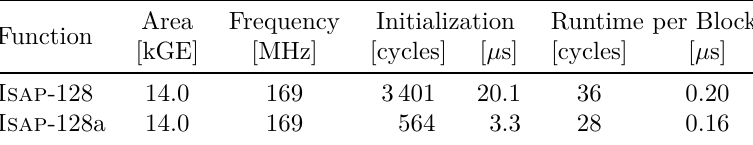
Table 4: Implementation of the AE modes (130